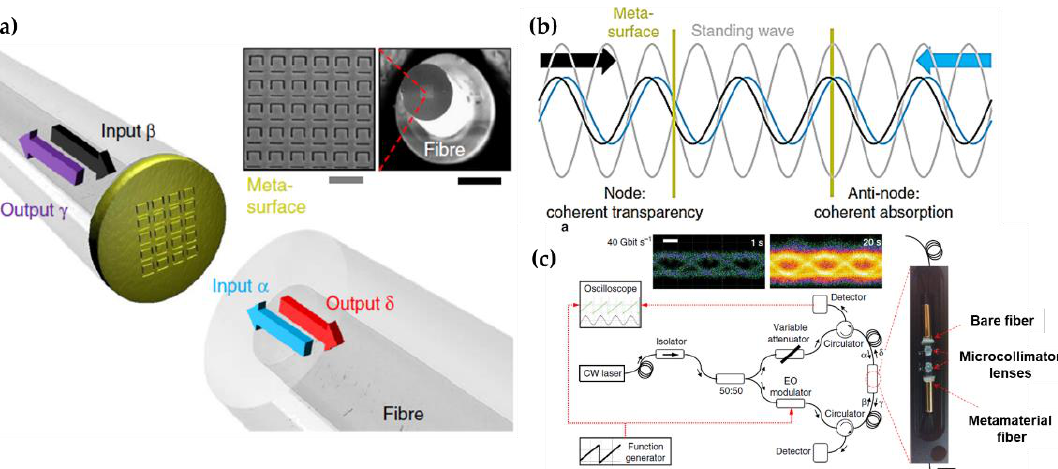
Figure 13. ( a ) Coherent optical input signals α and β interact on a metasurface absorber, generating output signals γ and δ. ( b ) The standing wave formed by the counterpropagating input signal. The metasurface could be placed either the node or anti-node where the optical absorption is suppressed or increased. ( c ) Schematic representation of the fully fiberized experimental setup with a photograph of the packaged fiber meta-device. Scale bar = 5 mm. Reprinted with permission from Ref. [86]. Copyright 2018 Nature Publishing